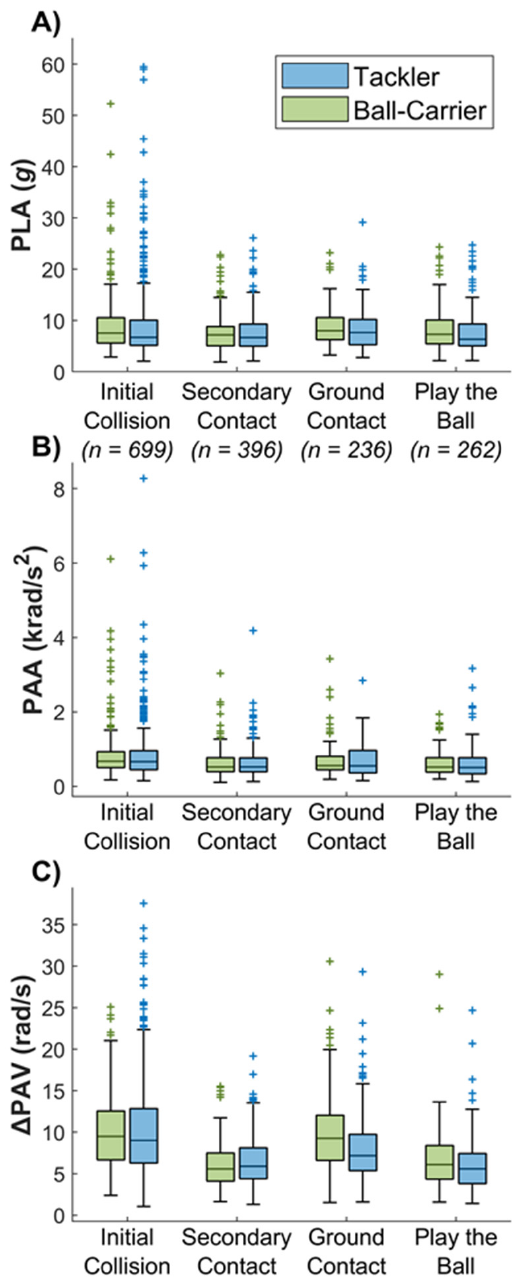
Figure 3. Box plots illustrating median and interquartile range (and outliers as crosses) ( A ) PLA, ( B ) PAA and ( C ) ∆ PAV for different stages of a tackle: initial collision, secondary, ground contact and play the ball.